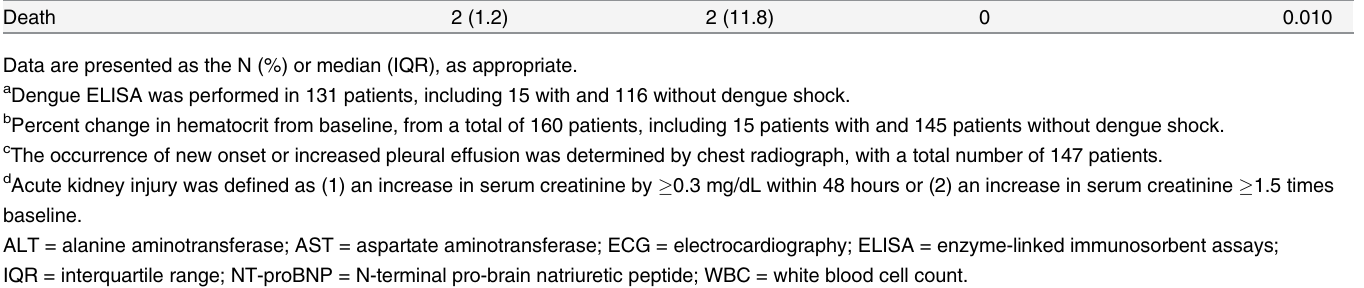
IVC parameters that correspond to a CVP (cid:3) 5 mmHg, the proportion of dengue shock patients who had IVCd < 1.5 cm and IVCc > 50% was significantly higher on day 4 (4/7 [57.1%]